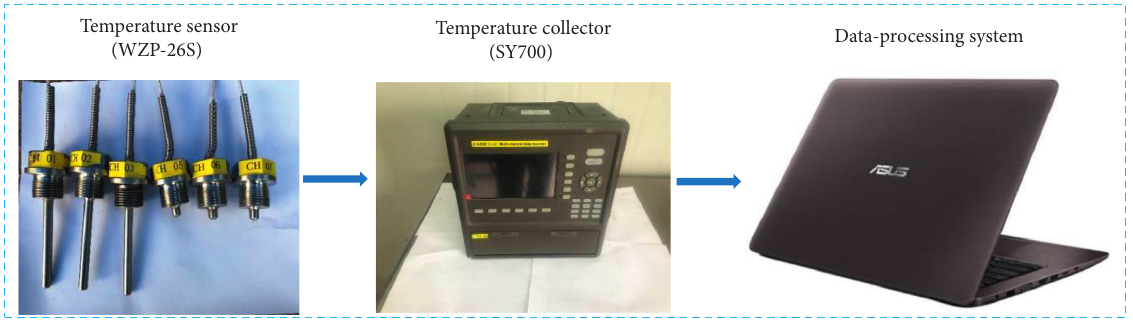
Figure 7: Data monitoring